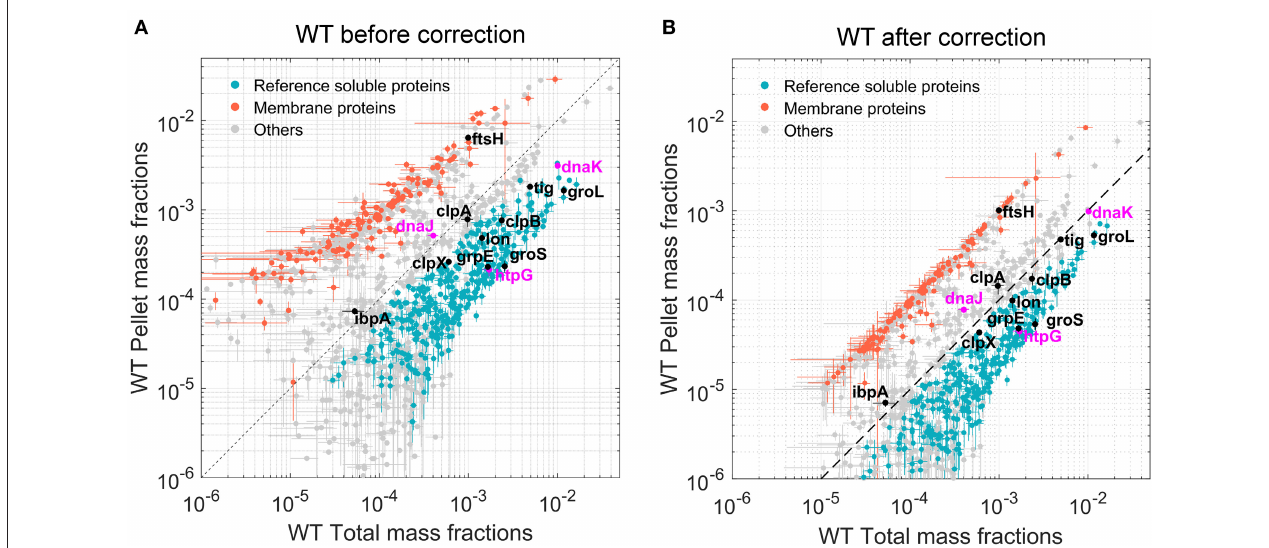
FIGURE 2 | Quantitation of the most abundant soluble and insoluble proteins in wild-type (WT) Escherichia coli cells. Scatter plot of the relative mean mass fractions of 1,421 proteins from WT W3110 E. coli that were significantly quantified in the total fraction containing both soluble and insoluble proteins (X-axis), against only in the insoluble pellet fraction, containing mostly the insoluble proteins (Y-axis). (A) Before correction for the overrepresentation of the insoluble proteins in the pellet fractions. (B) After correction. Orange dots: 281 membrane proteins identified as such by the Uniprot database. Blue dots below the hatched line: proteins with a significant solubility index equal or > 90%. Gray circles: other less significantly soluble proteins. Magenta dots: DnaK, DnaJ, and HtpG. Black dots, other canonical chaperones and major proteases.